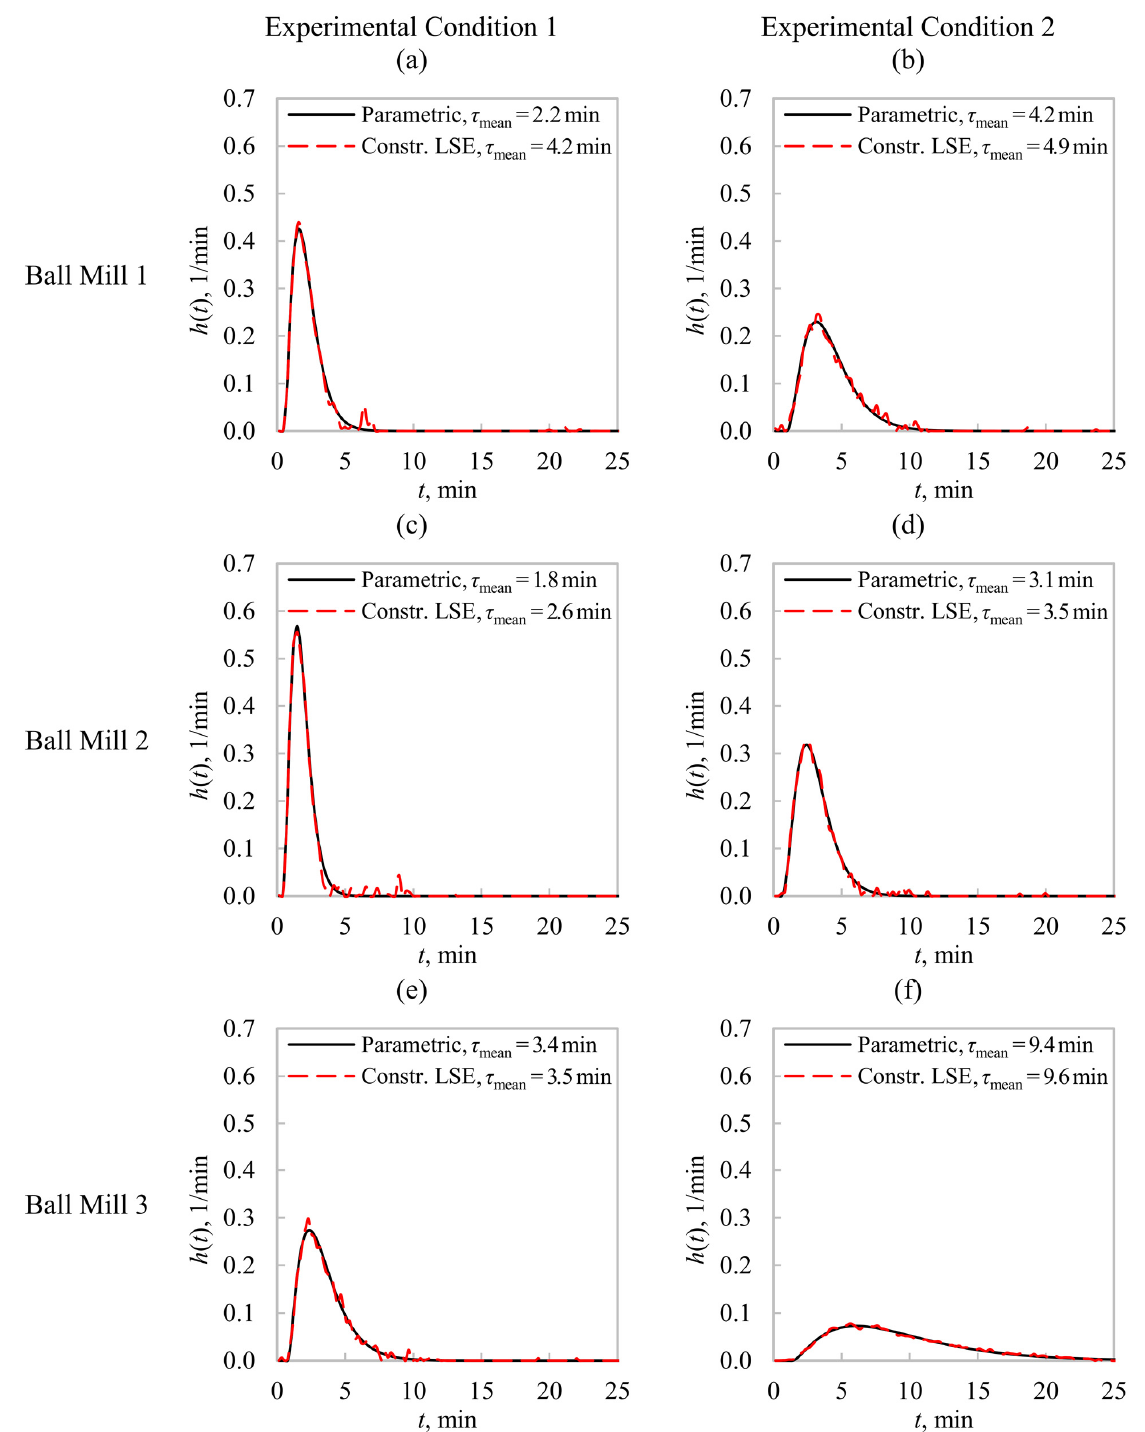
Figure 4. Estimated RTDs for solids from the constrained LSE and parametric approaches: Ball Mill 1 ( a ) Experimental Condition 1, ( b ) Experimental Condition 2; Ball Mill 2 ( c ) Experimental Condition 1, ( d ) Experimental Condition 2; Ball Mill 3 ( e ) Experimental Condition 1, ( f ) Experimental Condition 2.